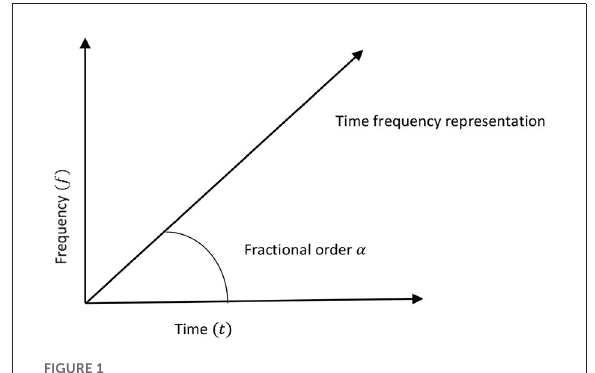
FIGURE1 The time-frequency plane (Namias,